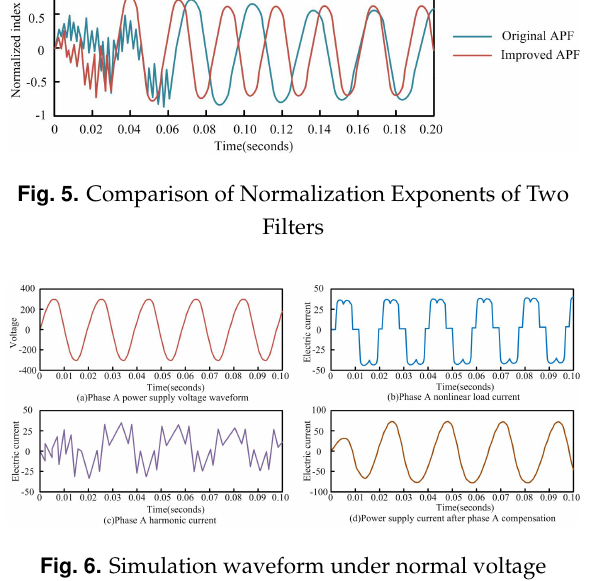
Fig. 6. Simulation waveform under normal